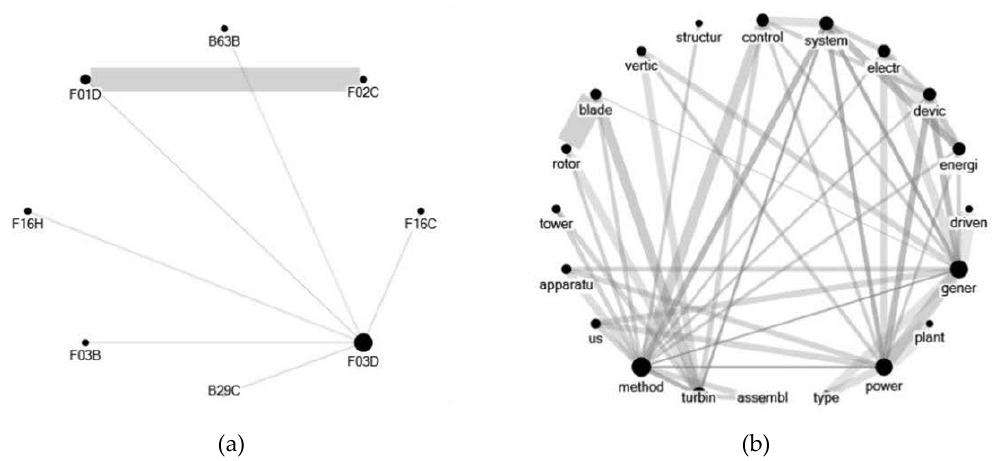
Figure 6. Mechanical engineering network graph to visualize ARM. (a) Mechanical engineering IPC Network; (b) Mechanical engineering Key Terms Network.